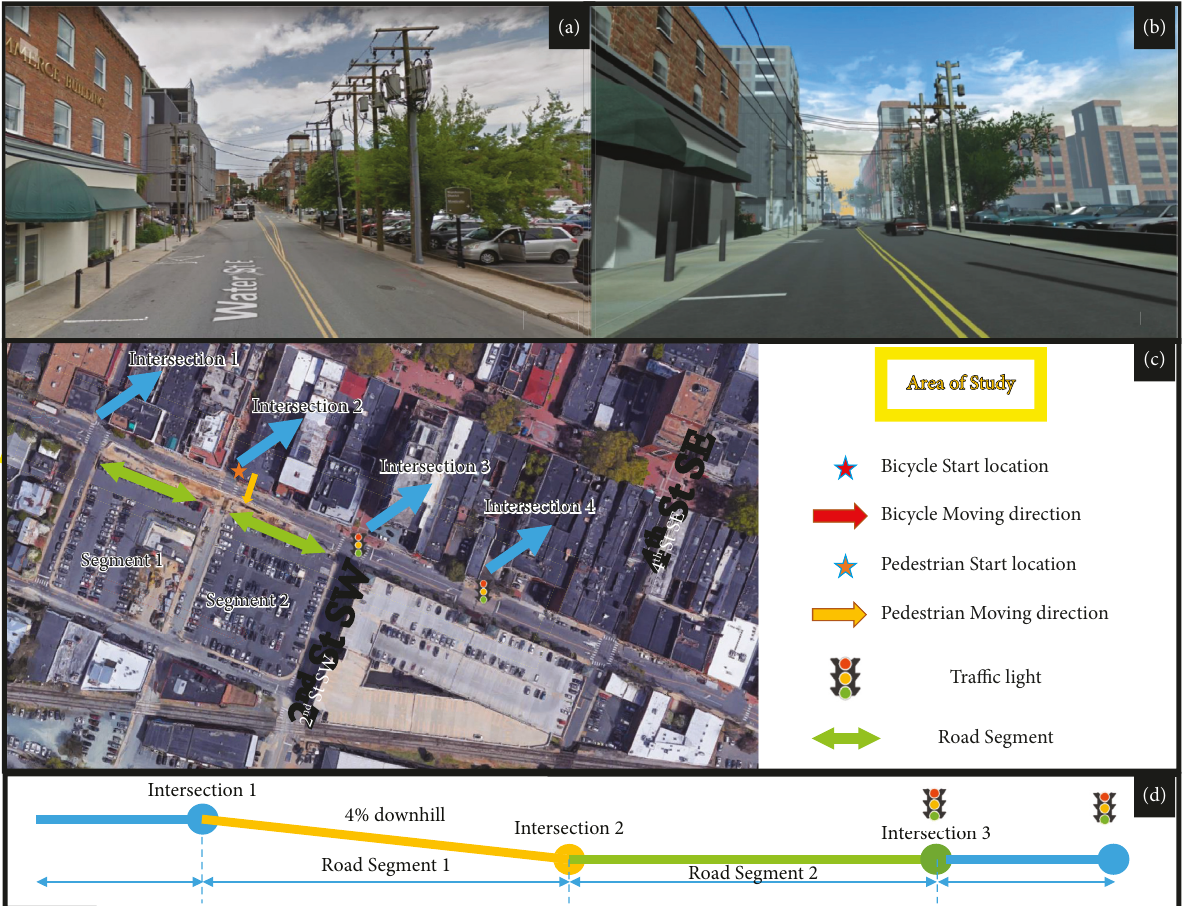
Figure 2: Comparison between (a) the real environment street map and (b) the IVE, (c) the map for the location of the real-world environment, and (d) vertical road (v) Physical Trek Verve bike: the main body structure of the bicycle simulator